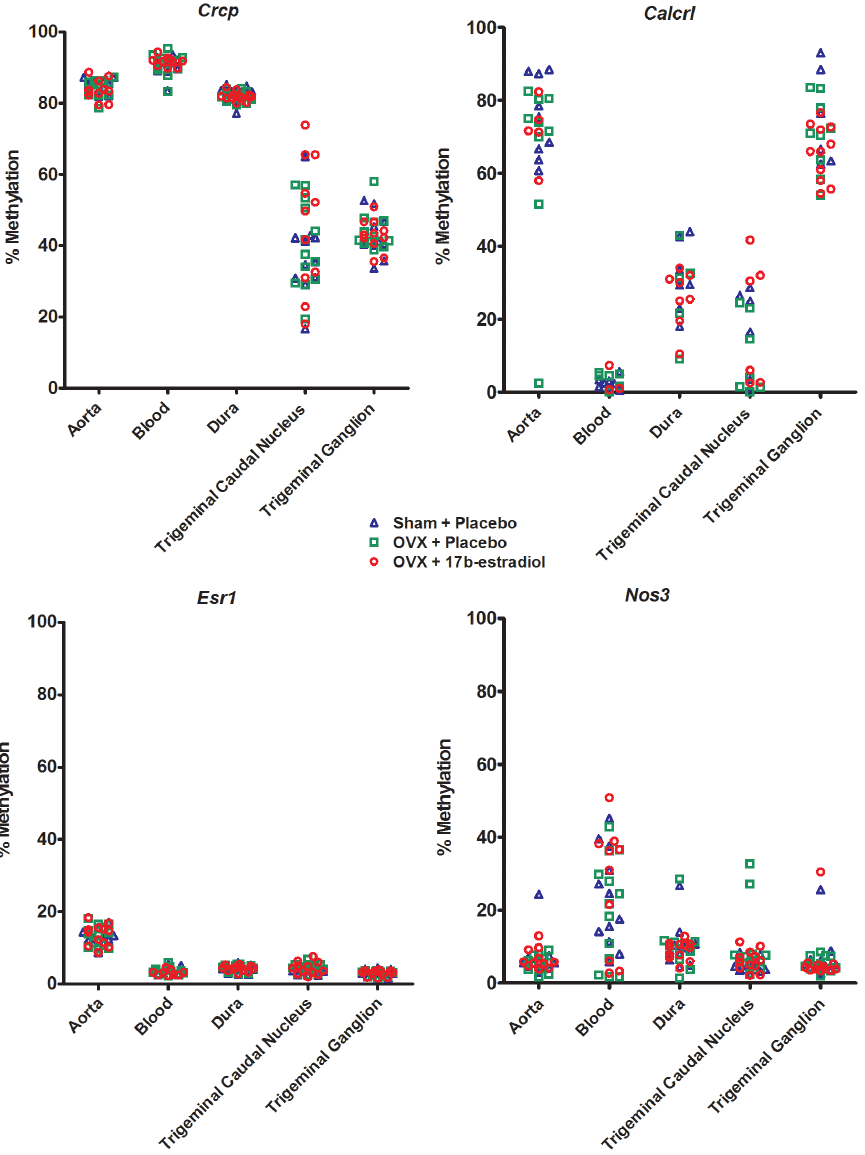
Figure 2. DNA methylation of Crcp , Calcrl , Esr1 and Nos3 in different tissues. Mean methylation of the promoter region of the Crcp (upper left panel), Calcrl (upper right panel), Esr1 (lower left panel) and Nos3 (lower right panel) genes is shown for the different tissues studied. Each symbol represents one animal and the different colors and symbols represent the treatment of the animals. Red circle: OVX + 17 b -estradiol; Green square: OVX + placebo; Blue triangle: sham + placebo.